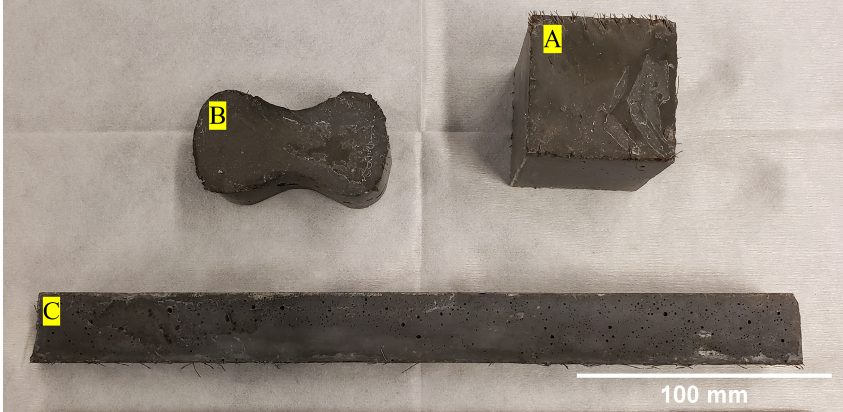
Figure 2. Different sample types used for mechanical testing. ( A ) compression cube (50 mm × 50 mm × 50 mm); ( B ) tension briquettes (at gage 25 mm × 25 mm); ( C ) flexural beam (25 mm × 25 mm × 305 mm).